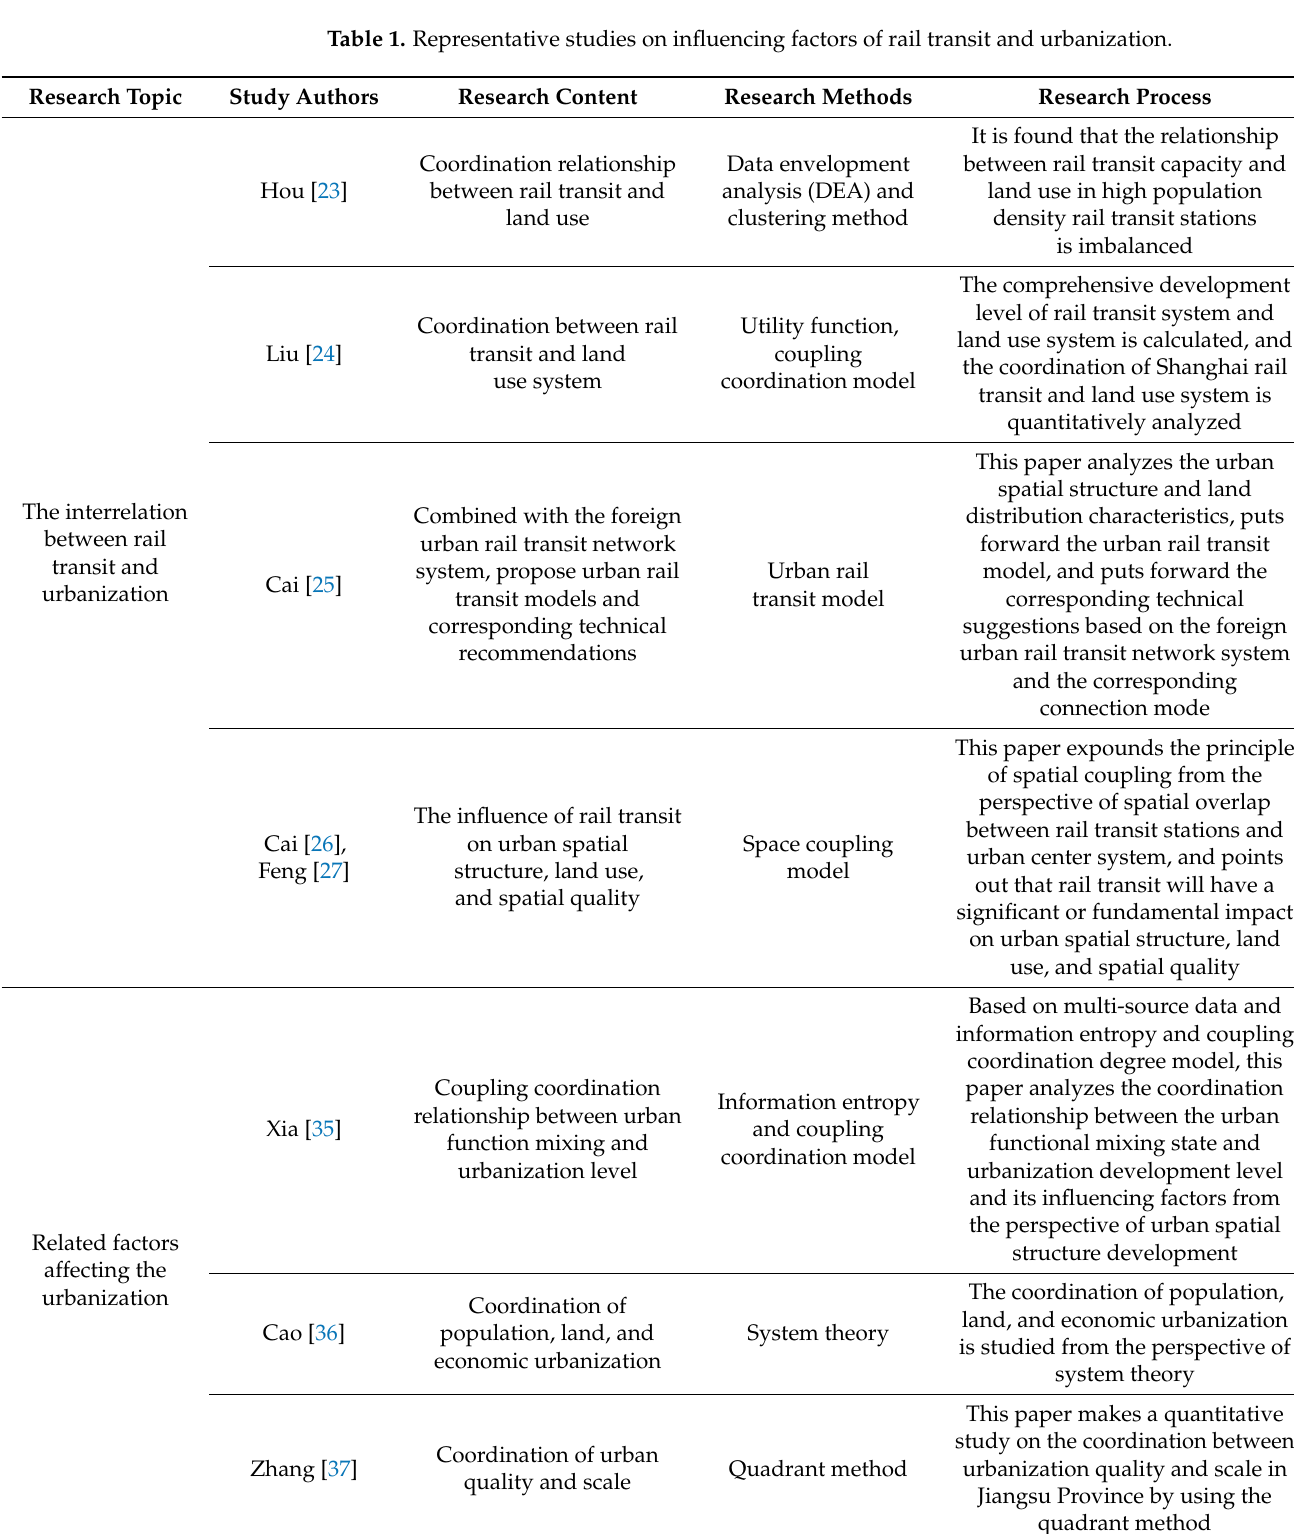
Table 1. Representative studies on influencing factors of rail transit and